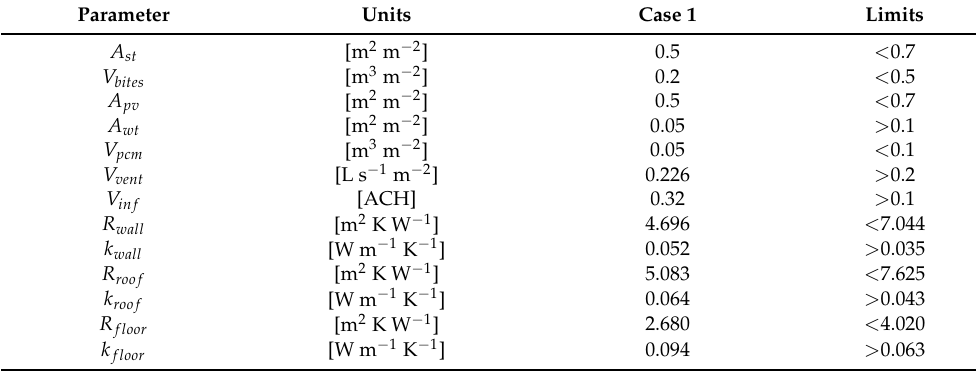
Table 5. System design parameters: Starting values and limits are